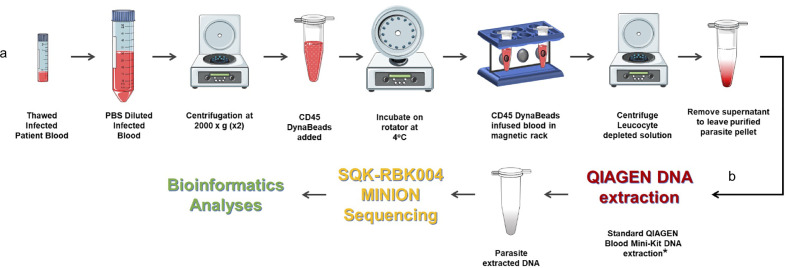
Protocol for processing low volume frozen whole blood samples from patients with malaria in preparation for third generation genome sequencing. (A) Human leucocyte depletion and (B) sequencing pipeline. *Human DNA was quantified using qPCR (Klaassen et al., 2003) and a standard curve derived from Human Genomic Control DNA (Applied Biosystems®, TaqMan®). In the absence of pure control parasite DNA, cycle threshold (ct) values from P. knowlesi qPCR (Divis et al., 2010) were normalised by volume and used to estimate parasite DNA enrichment following human DNA depletion. Parts of the figure are conceptualised and adapted using Servier Medical Art, Servier: https://smart.servier.com.